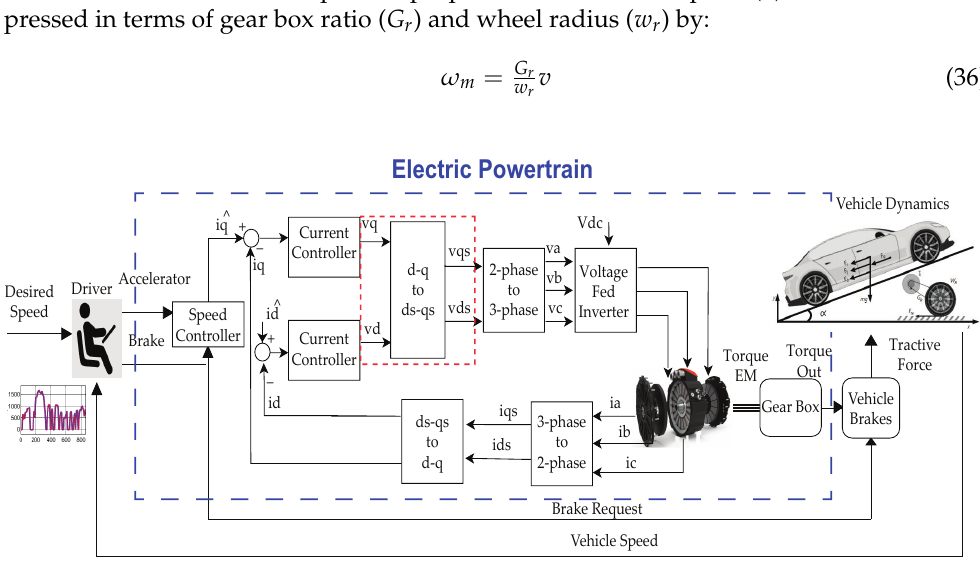
Figure 5. Electrified Powertrain block diagram.